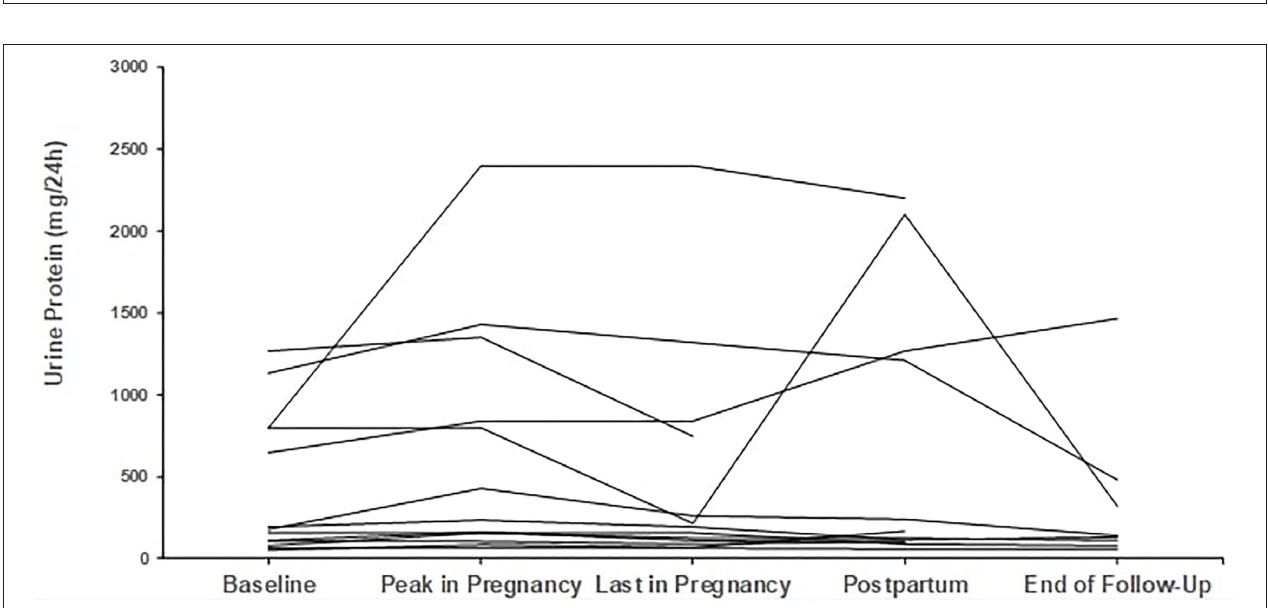
FIGURE 3 | Trends in proteinuria in patients with primary glomerular diseases ( n = 13). Individual trends in proteinuria at five time points: baseline, peak during pregnancy, last pregnancy visit, postpartum, and end follow-up.